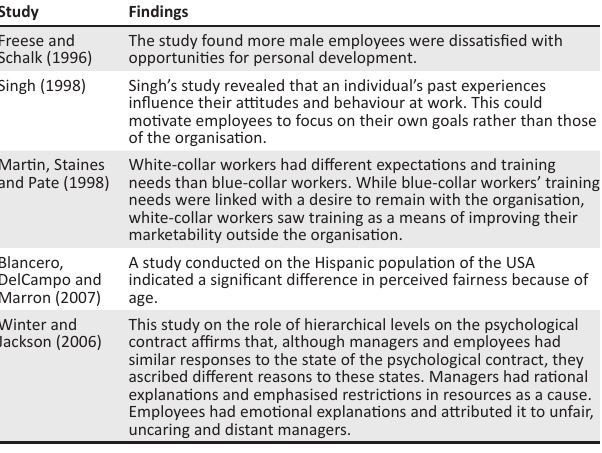
TABLE 1: Factors influencing the development of psychological